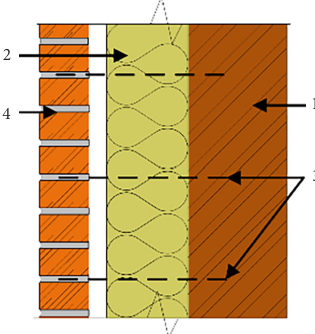
Figure 1. Solution of layered wall: 1 – construction